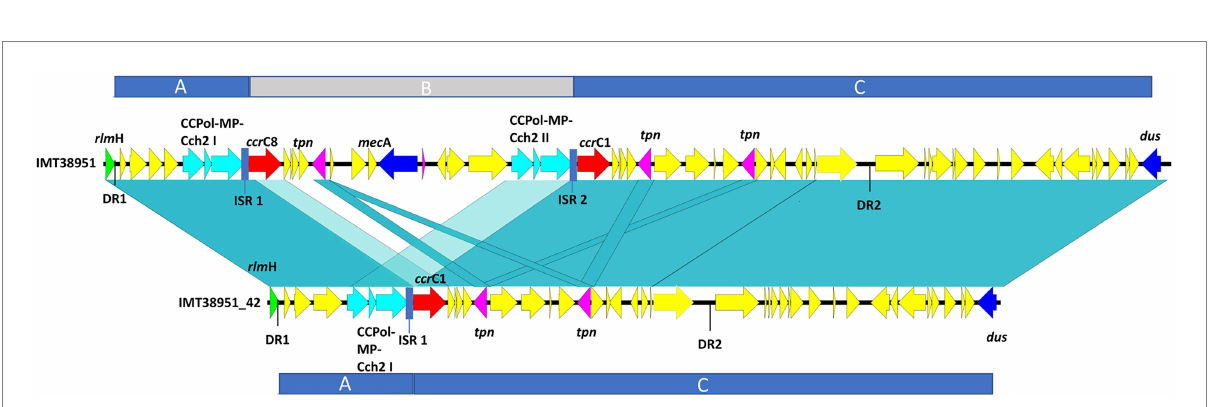
FIGURE 2 Sequence comparison of IMT38951 and IMT38951_42 from rlm H (previously: orf X) to dus (previously orf Y). Repetitive elements and homologues regions challenged the precise reconstruction of MRSA IMT38951 and its isogenic descendant lacking SCC mec Vc (region B). Since sequence identities of genes and intergenic spacer regions present in this region range from 98/99% (light blue-green) to 100% (blue-green), including sequences and genes that flank (regions A and C) the missing SCC mec element in IMT38951_42. DR, direct repeat of 15 bp length; CCPol-MP- Cch2, operon containing an A-family DNA polymerase (CCPol) together with a small protein lacking conserved domains (“middle protein,” MP) as well as a putative helicase (Cch2) (Bebel et al., 2020); ccr C, chromosomal cassette recombinase C; tpn , transposase associated with insertion element (IS) 431; ISR, intergenic spacer region of 224 bp